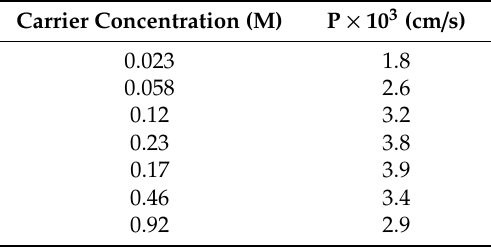
Table 4. Variation of gold(III) permeation with the carrier